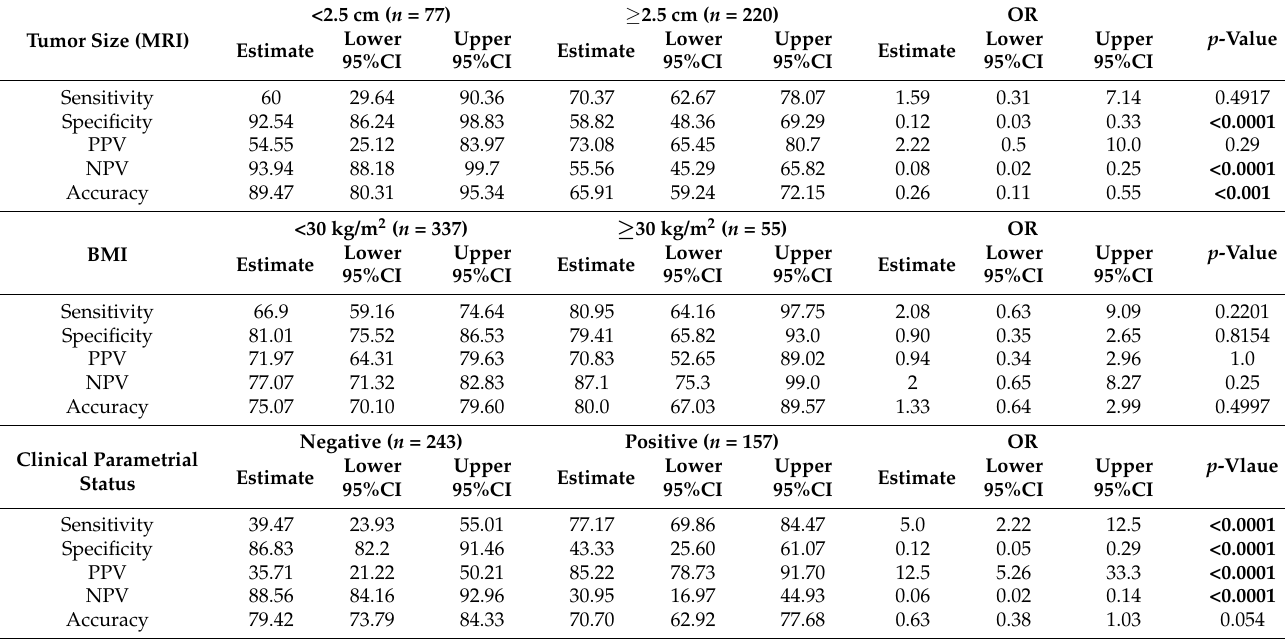
Table 3. Factors influencing the diagnostic performance of MRI in detecting pathologically confirmed parametrial tumor